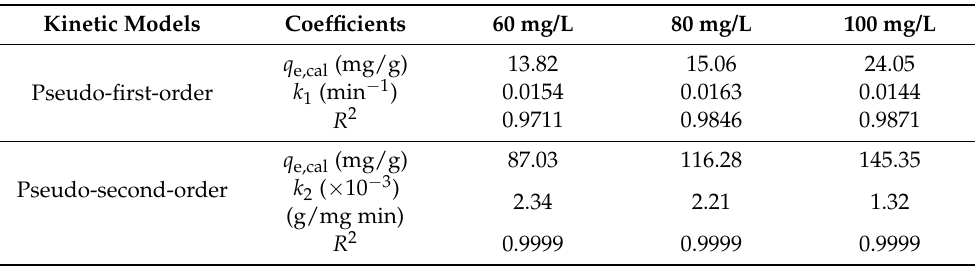
Figure 8. Fitting of pseudo-first-order ( a ) and pseudo-second-order kinetic ( b ) models for the ad- sorption process. adsorption process. Table 2. Kinetic parameters of two models for MB Table 2. Kinetic parameters of two models for MB adsorption.